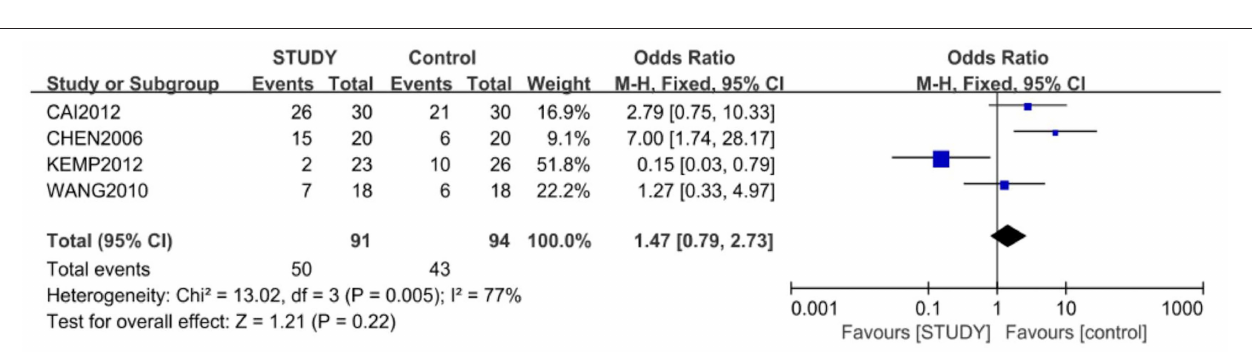
FIGURE 3 | Comparison of response rate between the study and control groups. The random-effects model was used for this analysis ( X 2 = 13.02, df = 3, P < 0.01, I2 = 77%). No difference in response rate was found between the two groups (OR = 1.47; 95% CI: 0.79 ∼ 2.73; Z = 1.21; P > 0.05).